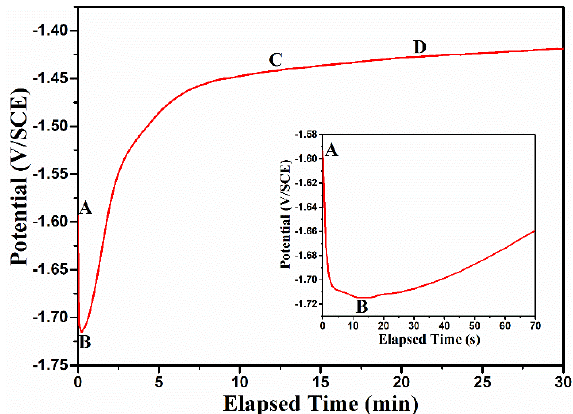
Figure 10. OCP curve during the conversion coating process.